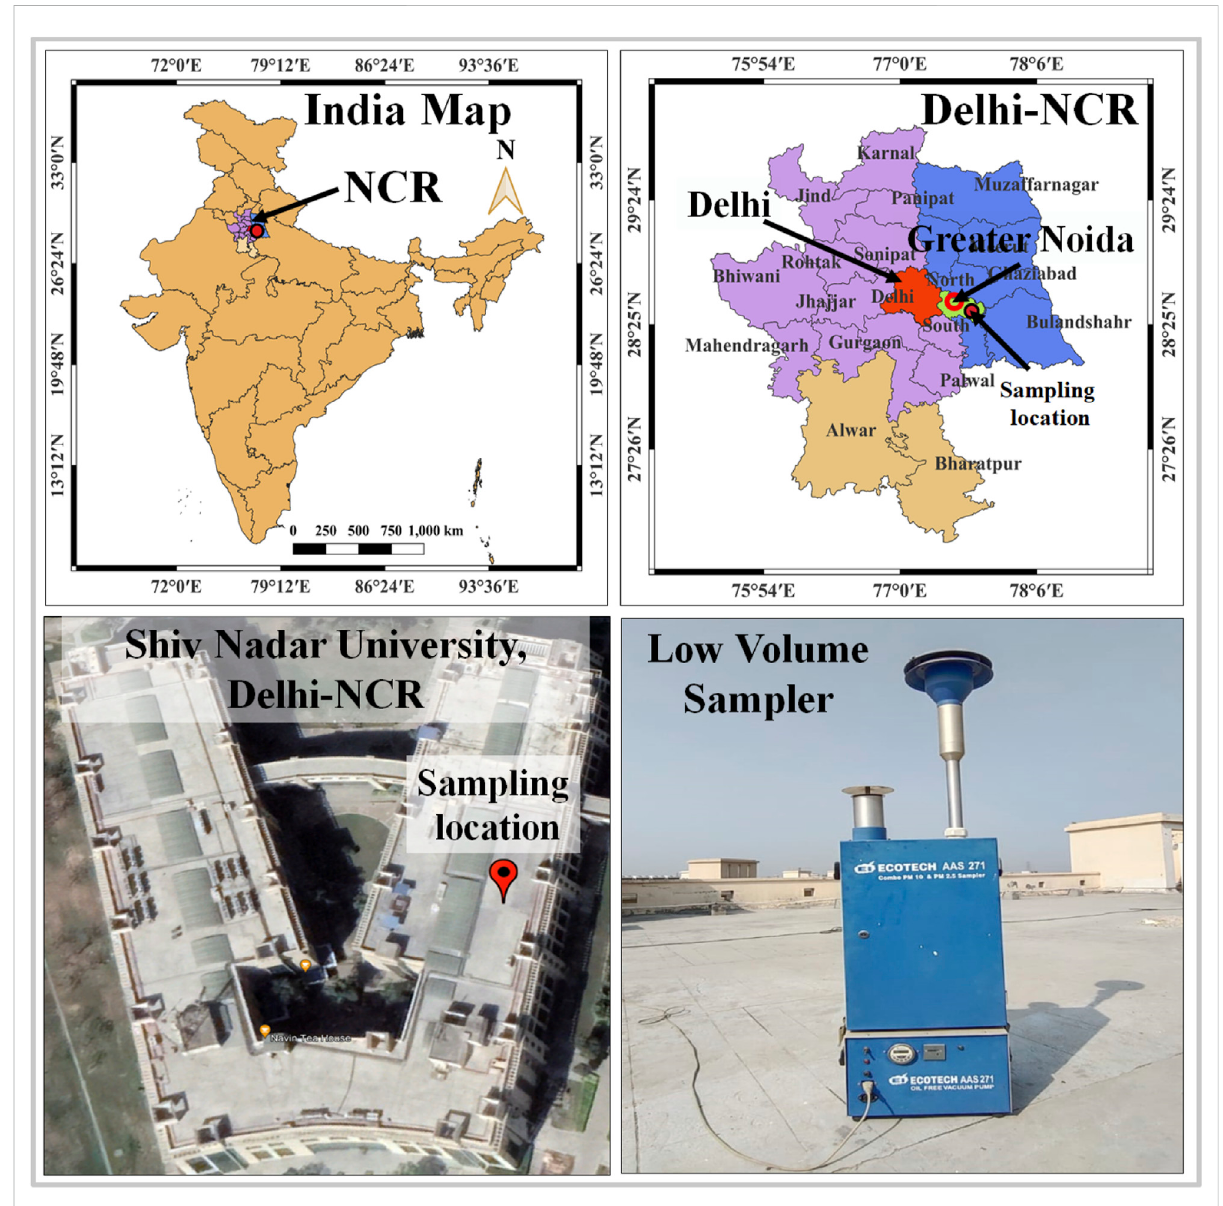
FIGURE 1 Geographic location of Delhi-NCR on the map of India, Greater Noida on the map of India, and Delhi-NCR, location of the sampling site and photograph of the sampler at the sampling